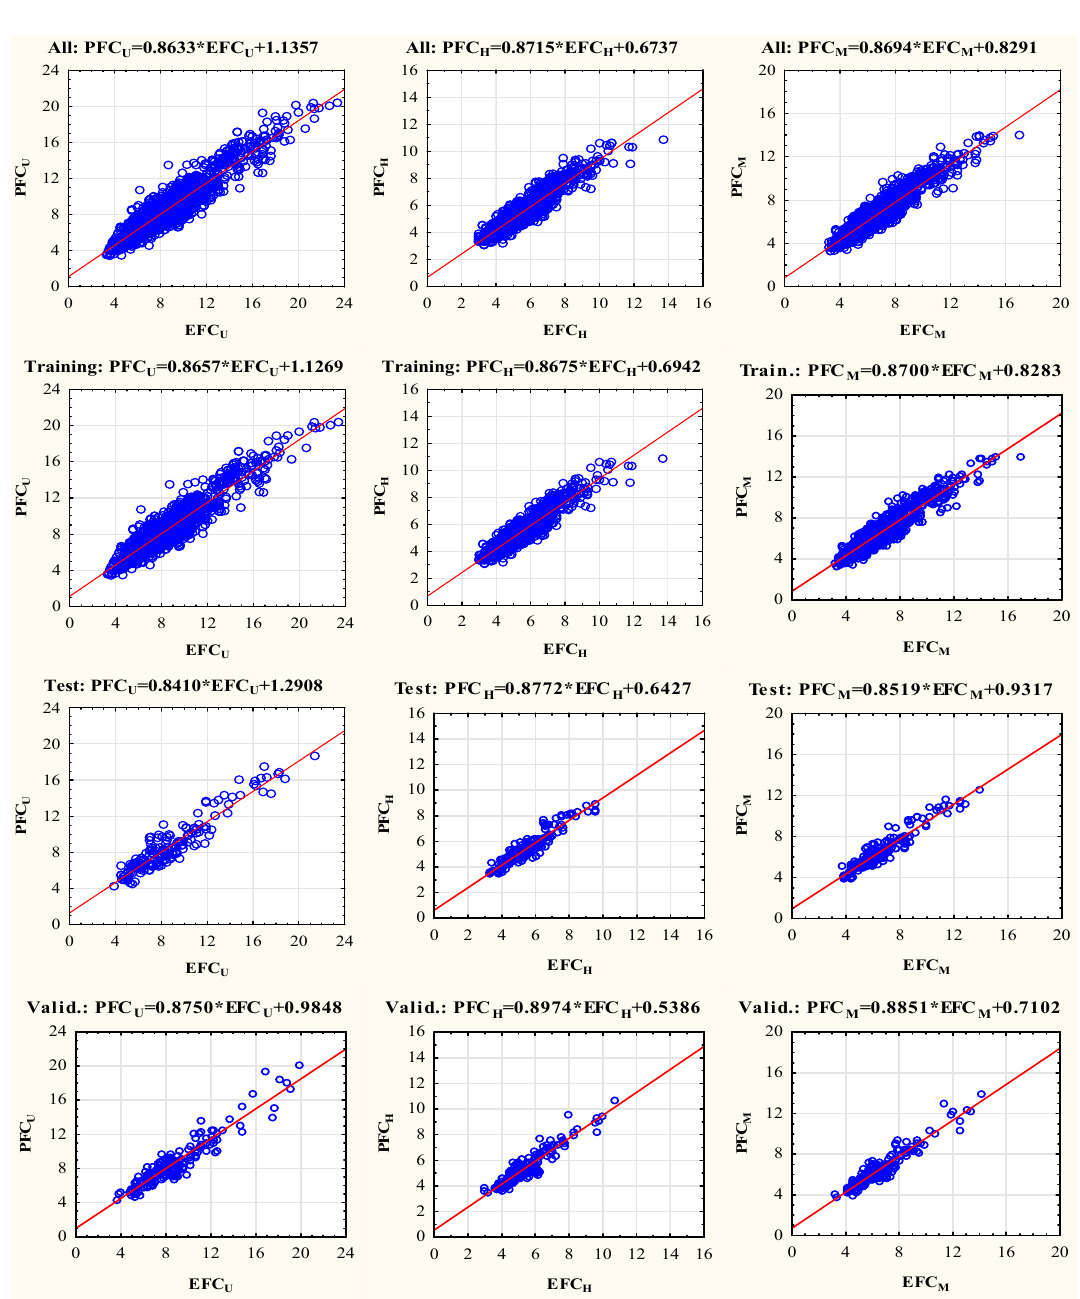
Figure 9. Regression plots of the MLP 20-10-3 artificial neural network. The global sensitivity analysis for the MLP 20-10-3 network, presented in Table 10, indicates the influence of the values of the individual input variables on the accuracy of the predictive model. The neural network has the highest sensitivity to the Type of charge B T variables and the lowest sensitivity to the Quantity of valves N V variables.